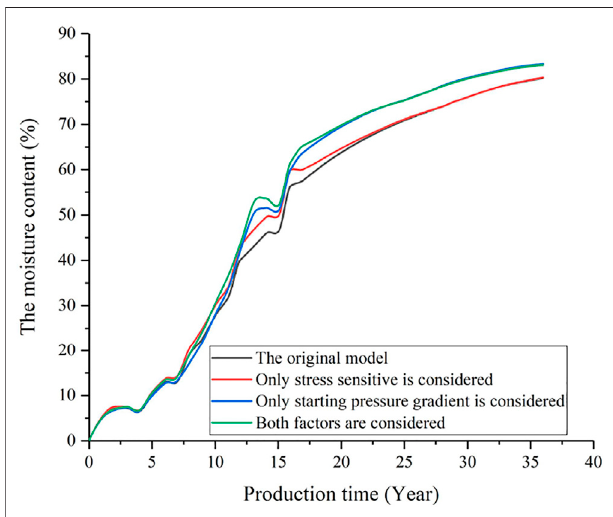
FIGURE 14 | Water cut curves of the Chang 6 reservoir considering different factors.